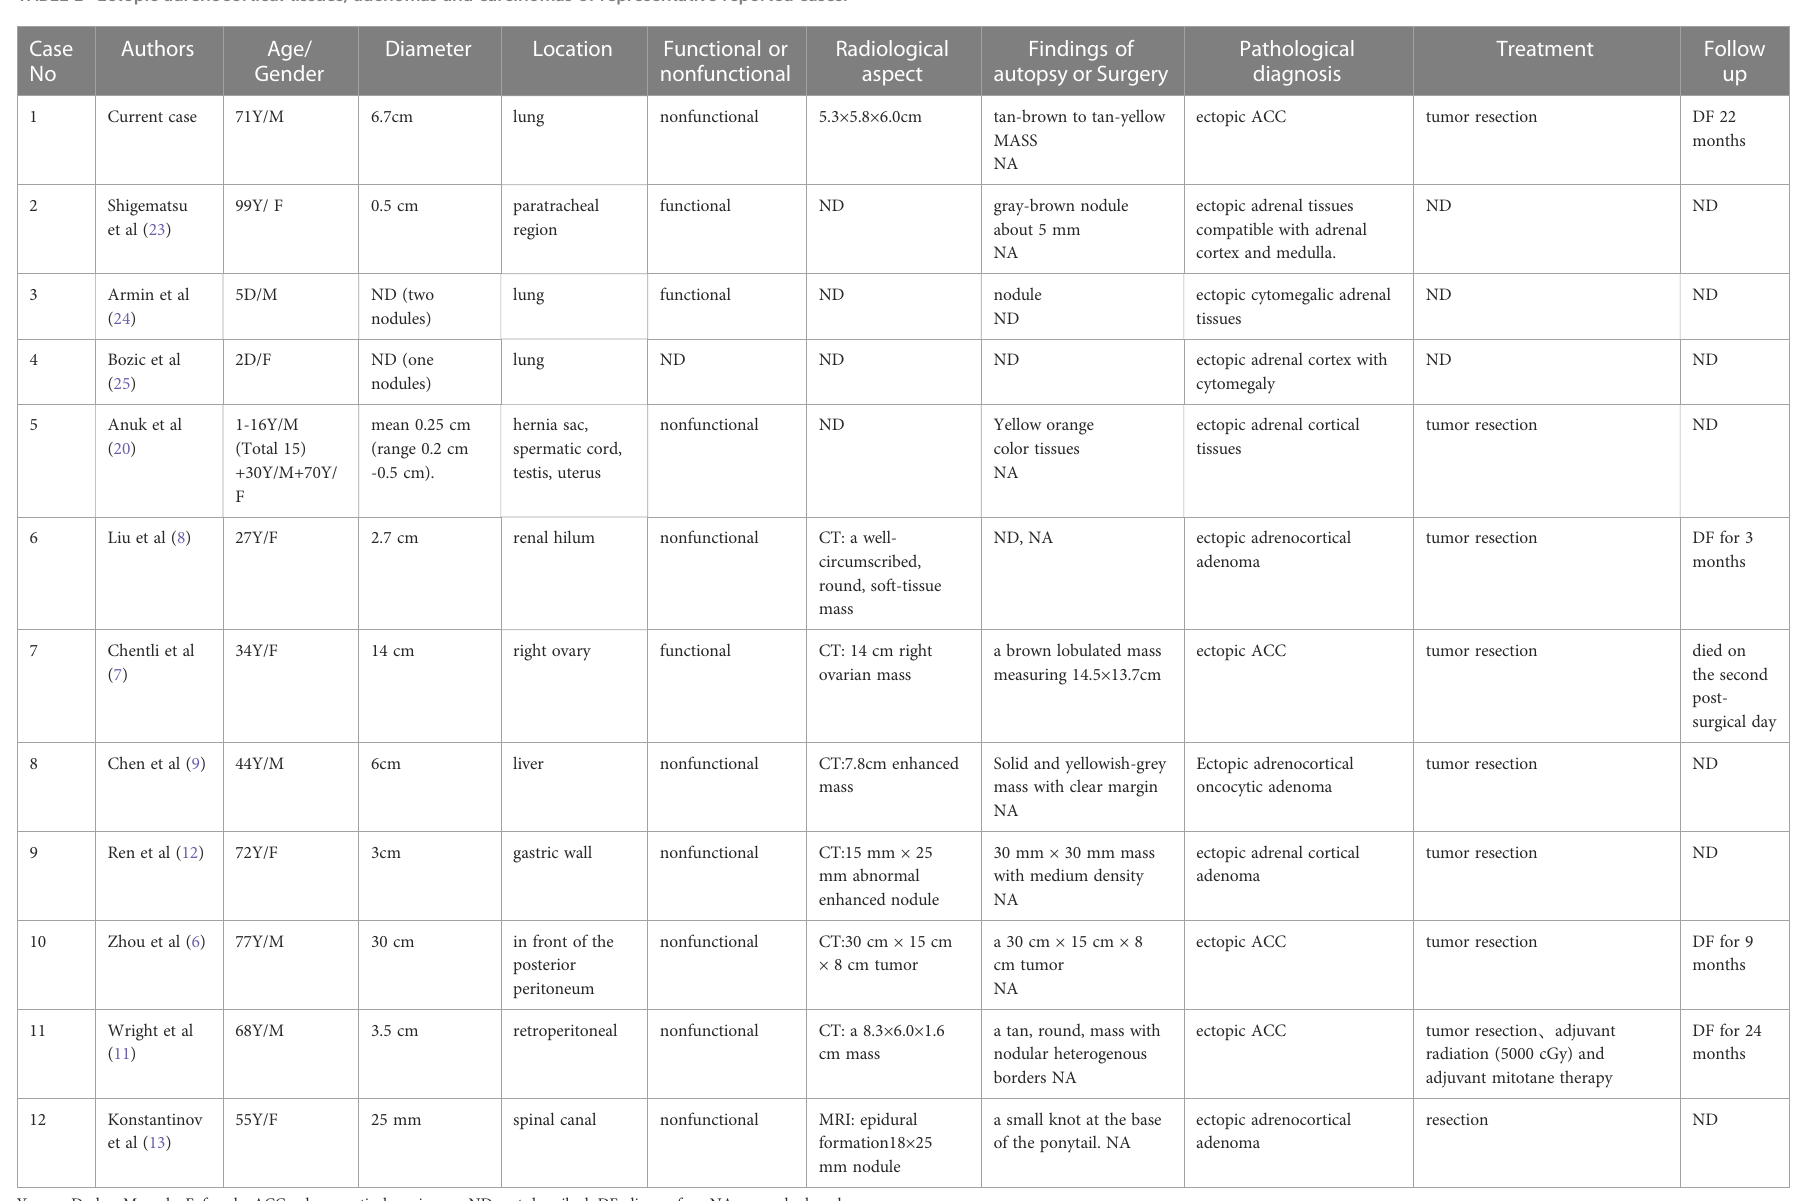
TABLE 1 Ectopic adrenocortical tissues, adenomas and carcinomas of representative reported